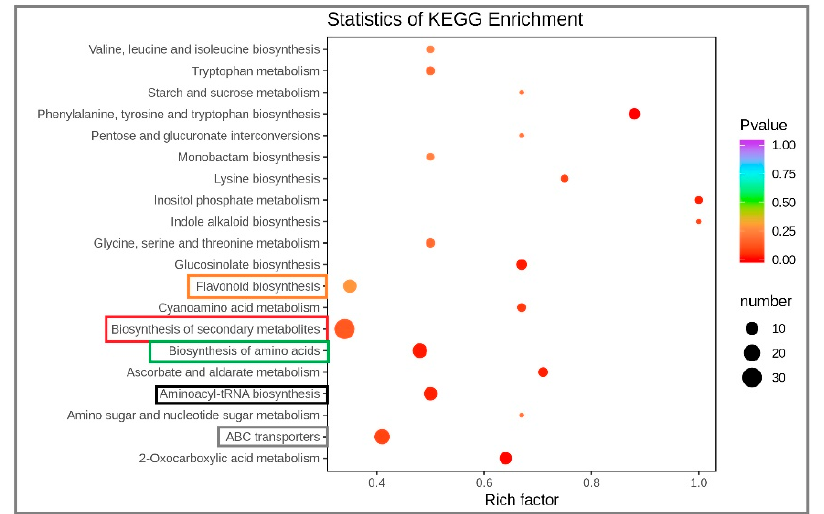
Figure 6. KEGG pathway enrichment of differential metabolites of water dropwort under soil culture (CK) and Yamasaki nutrient solution (NK). The abscissa indicates the rich factor corresponding to each path, the ordinate is the path name, the color of the point is the p − value, and the redness level indicates that the enrichment is more significant. The size of the dots represents the number of differential metabolites enriched.